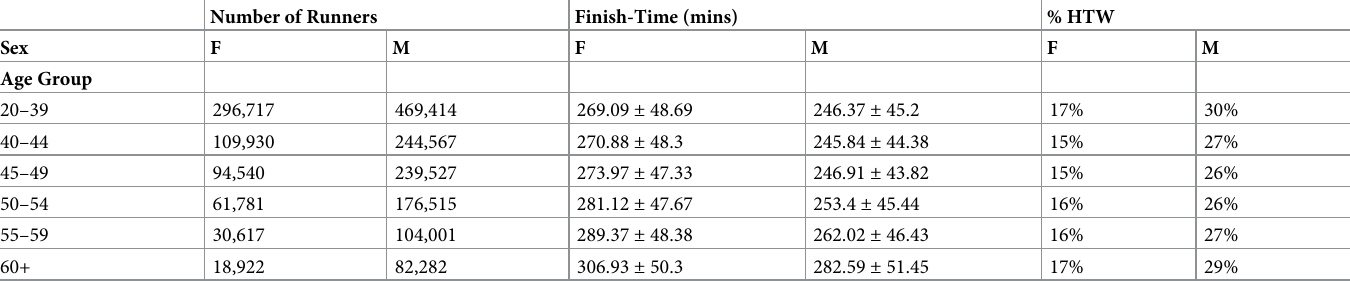
Table 4. An overall summary of the repeaters dataset by age group showing the number of male ( M ) and ( F ) runners in each age group along with their average fin- ish-times and the percentage of male and female runners hitting the wall, based on the defintion adopted here. Number of